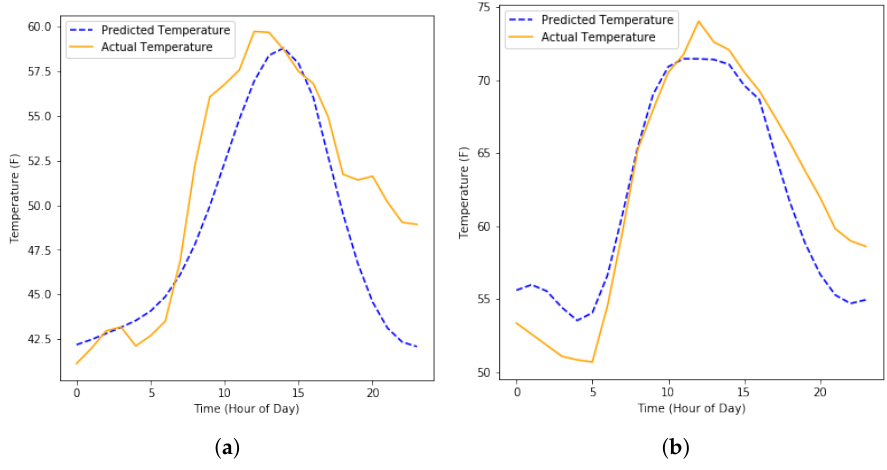
Figure 9. A smooth predicted (blue dashed curve) and a jagged actual (orange solid curve) Temperature curve for two different days in Stanford, CA. ( a ) Day 1; ( b ) Day